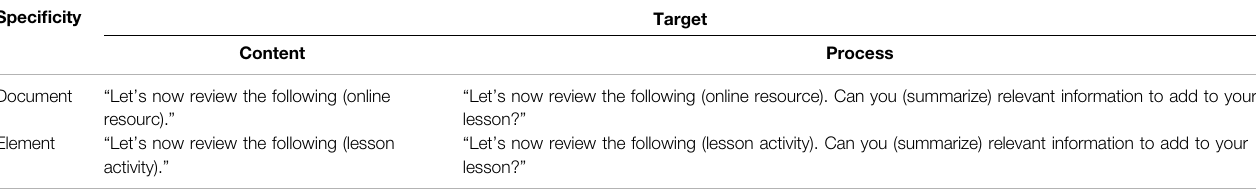
TABLE 1 | The 2x2 framework for prompts as instructional scaffolds in network-based